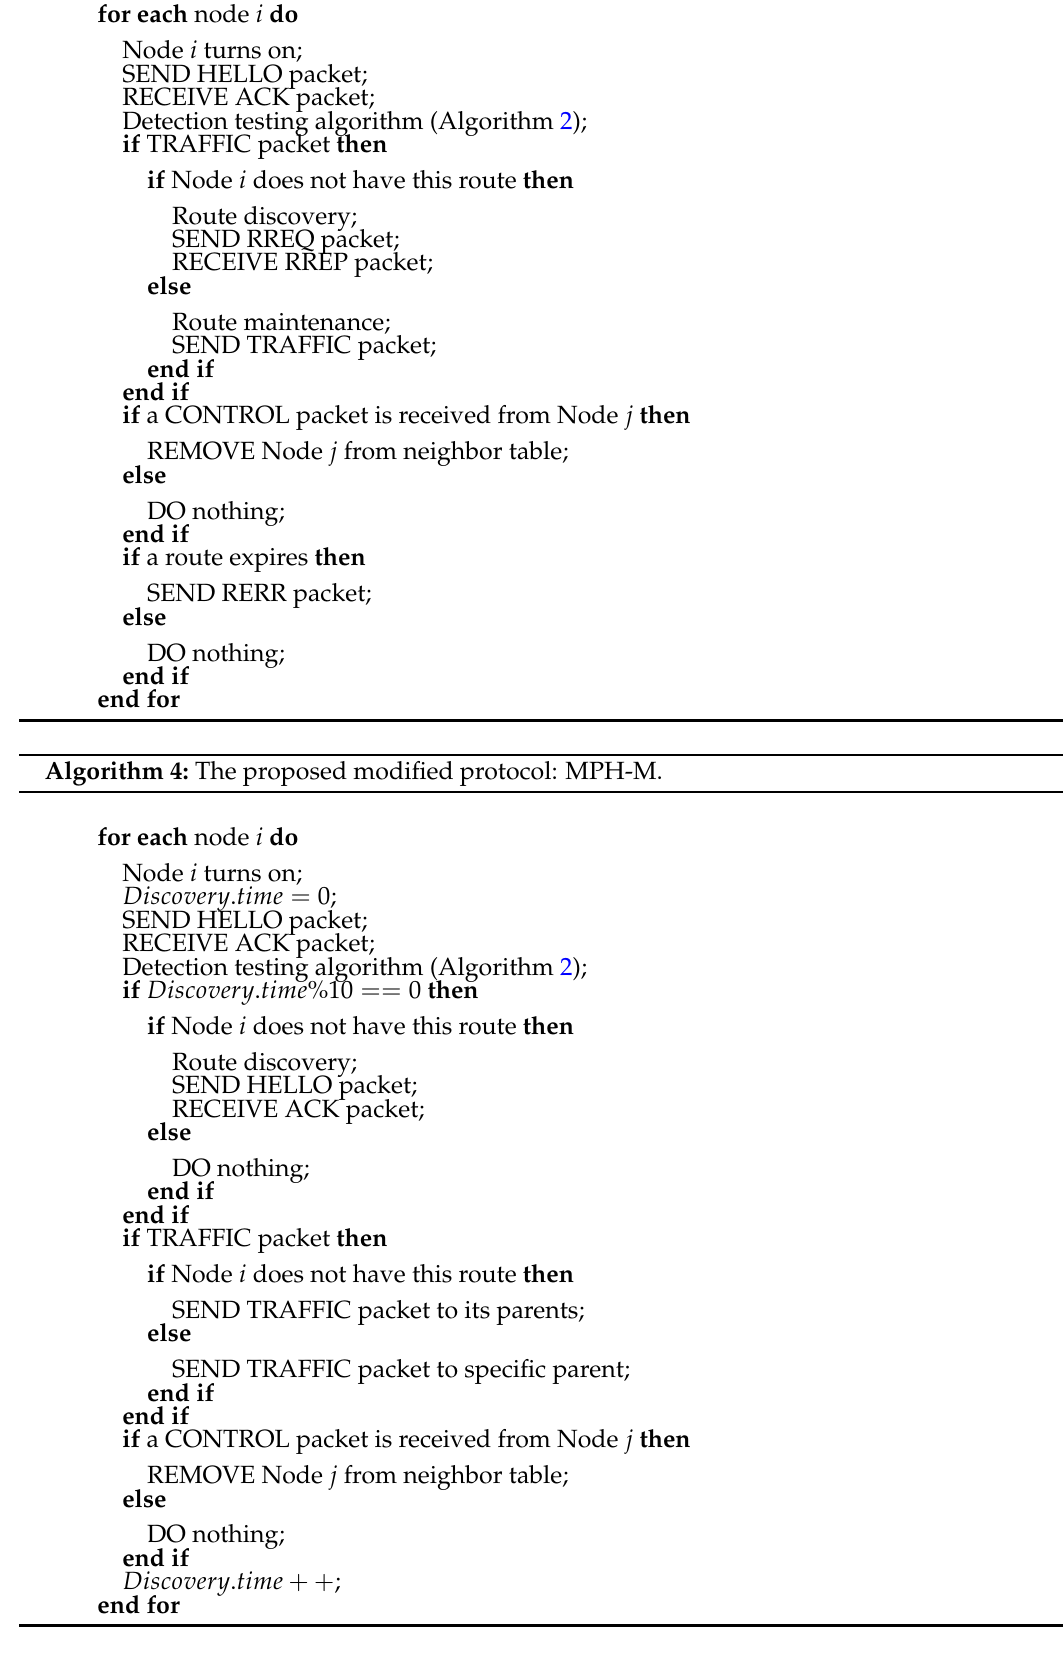
Algorithm 3: The proposed modified protocols: AODV-M and DSR-M. for each node i do